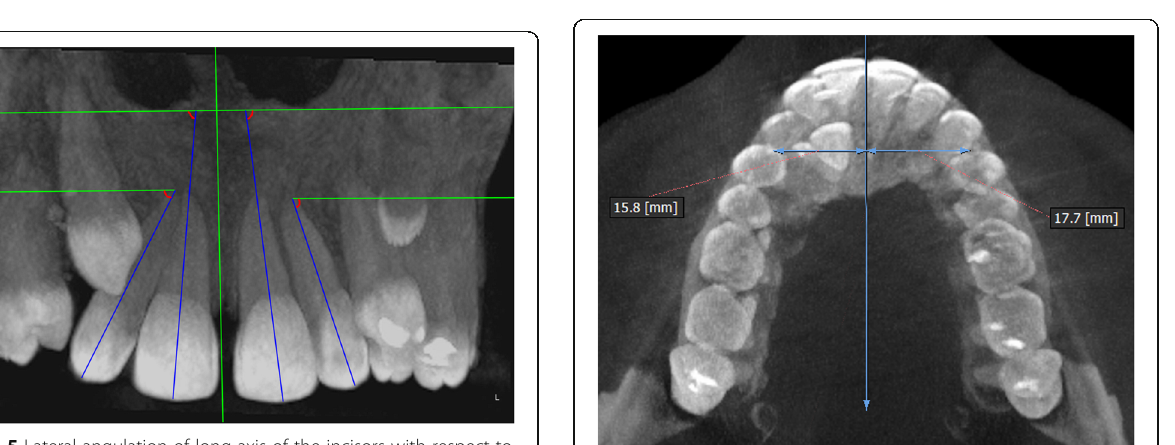
Fig. 5 Lateral angulation of long axis of the incisors with respect to the nasal horizontal plane. Value of the external angle of the longitudinal axis of the central and lateral incisors of both quadrants with respect to the tangent of the nostril floor